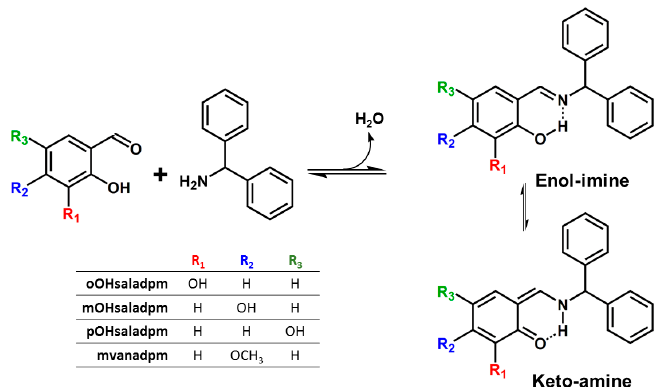
Scheme 1. View of molecular structures and keto-enol tautomeric equilibrium of four o -hydroxy imines derived from α -aminodiphenylmethane. sal , salicylaldehyde; adpm , aminodiphenylmethane; mvan , m